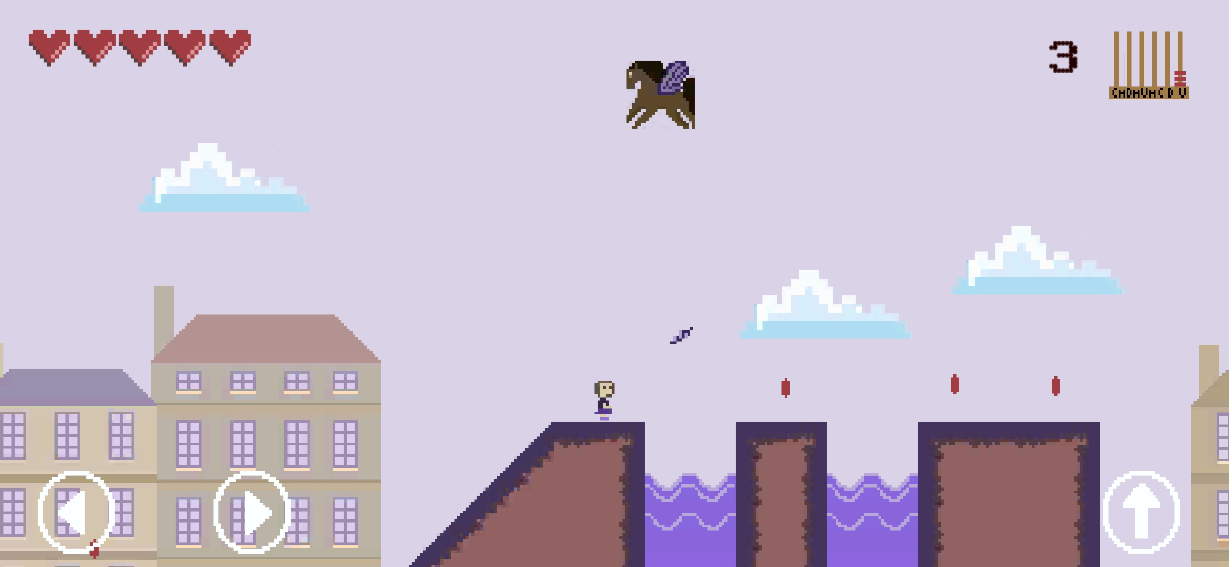
Figure 4. Screenshot of the first phase of the game.